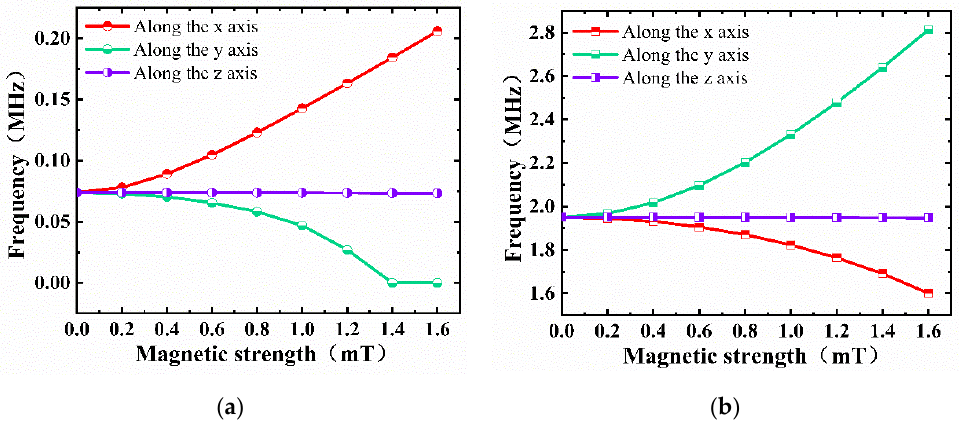
Figure 3. Resonance frequency versus magnetic field in different directions when ( a ) beam is clamped on two edges, and ( b ) beam is clamped on four edges.